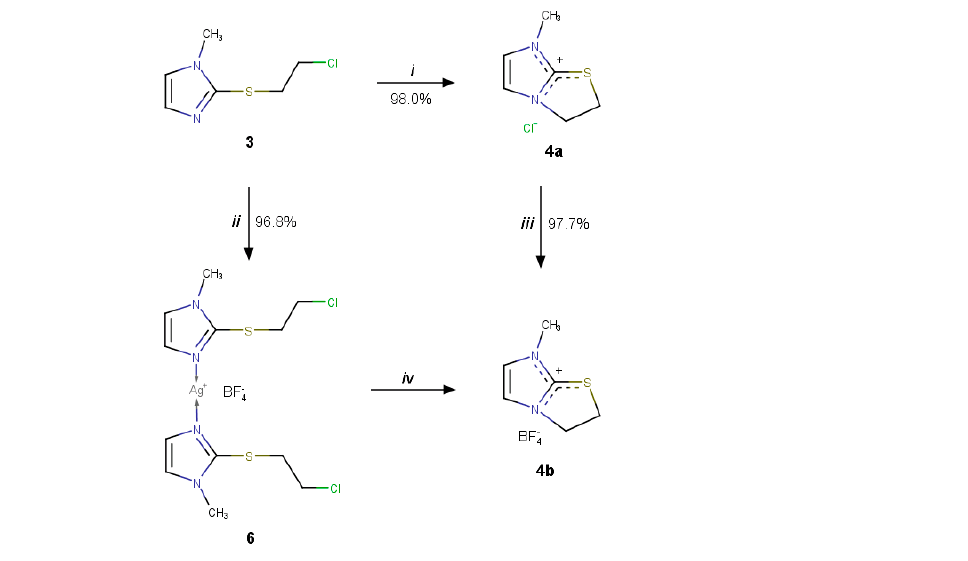
( b ) Figure 7. ( a ) Molecular structure of 4b with the atomic numbering scheme (only major parts of the disordered tetrafluoroborate ion are labeled); ( b ) projection down the crystallographic a axis. The crystal structure of 4b consists of planar heterobicyclic cations and tetrafluorob-